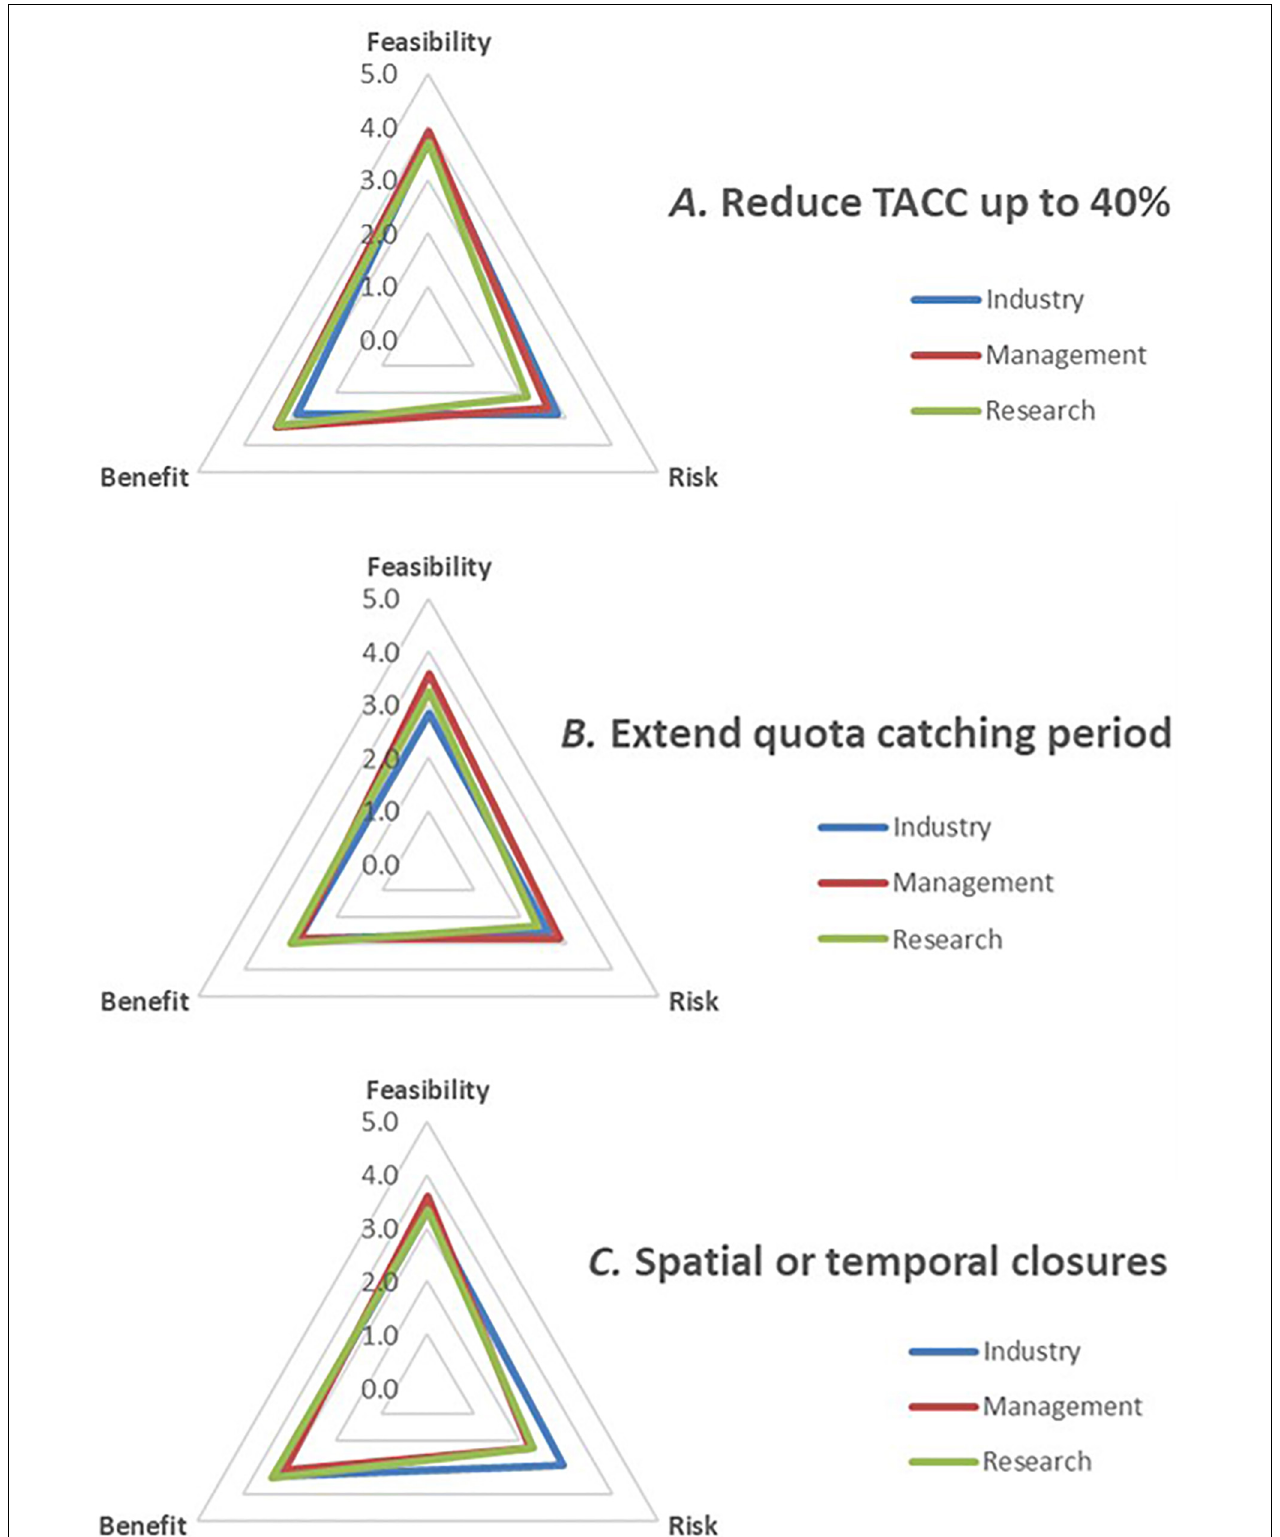
FIGURE 4 | Comparison of the evaluation by industry, management and research respondents of feasibility, risk, and benefit of three common adaptation options: Reduce TACC (A) ; Extend quota catching period (B) ; and Spatial or temporal closures (C) .